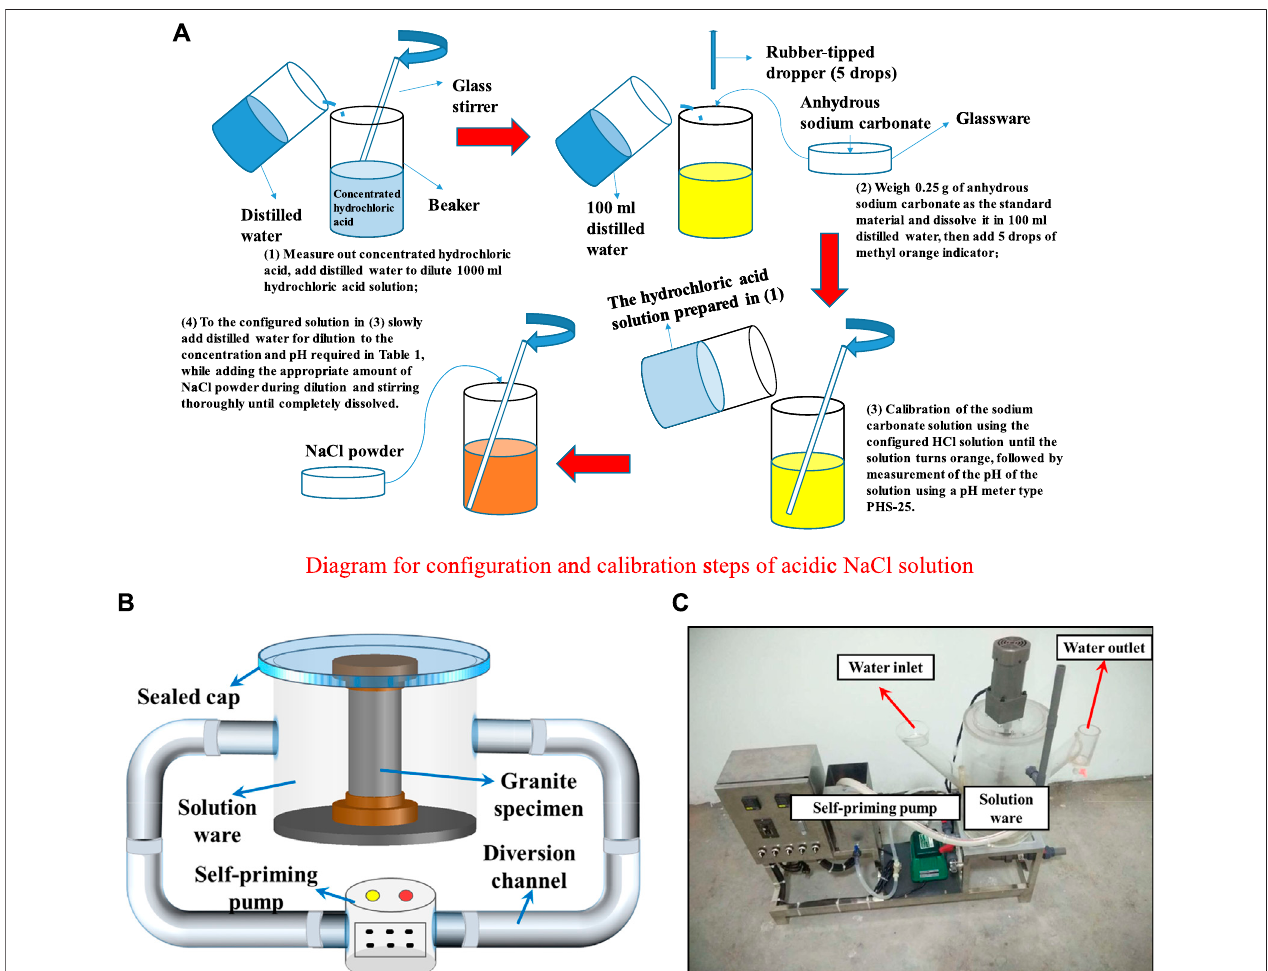
FIGURE2| Realizationofdynamicwaterconditions. (A) Diagramforcon fi gurationandcalibrationstepsofacidicNaClsolution. (B) Schematicdiagramofthewater scouring device. (C) Water chemical solution scouring device.